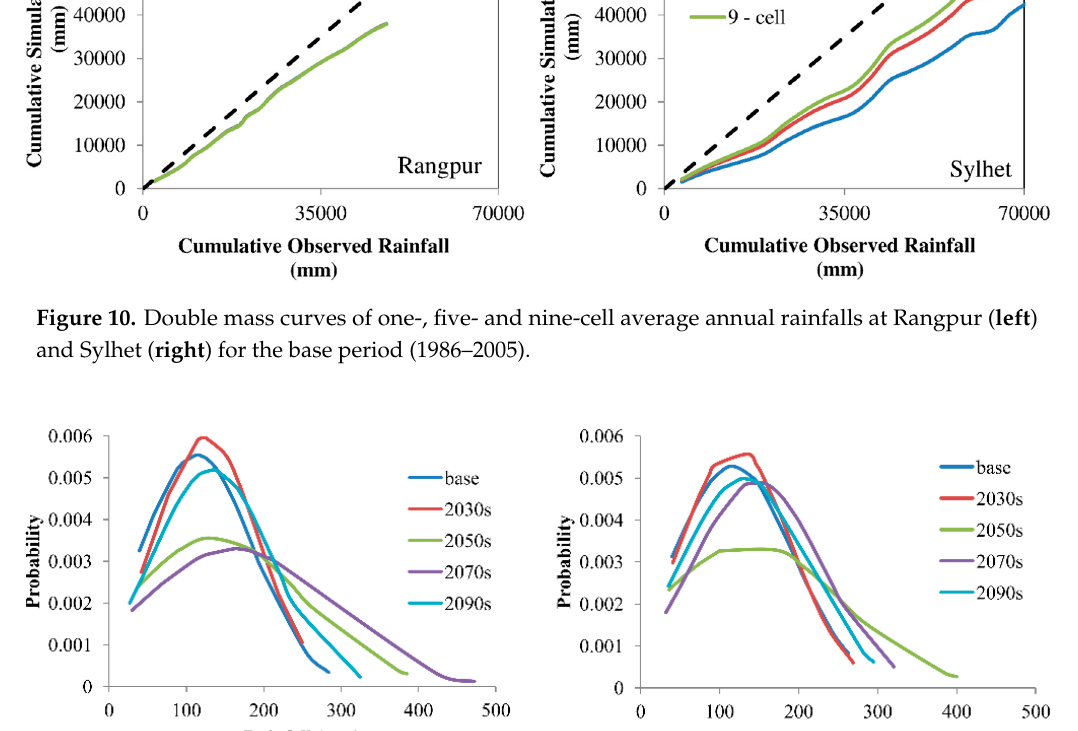
Figure 10. Double mass curves of one-, five- and nine-cell average annual rainfalls at Rangpur ( left ) and Sylhet ( right ) for the base period (1986–2005).